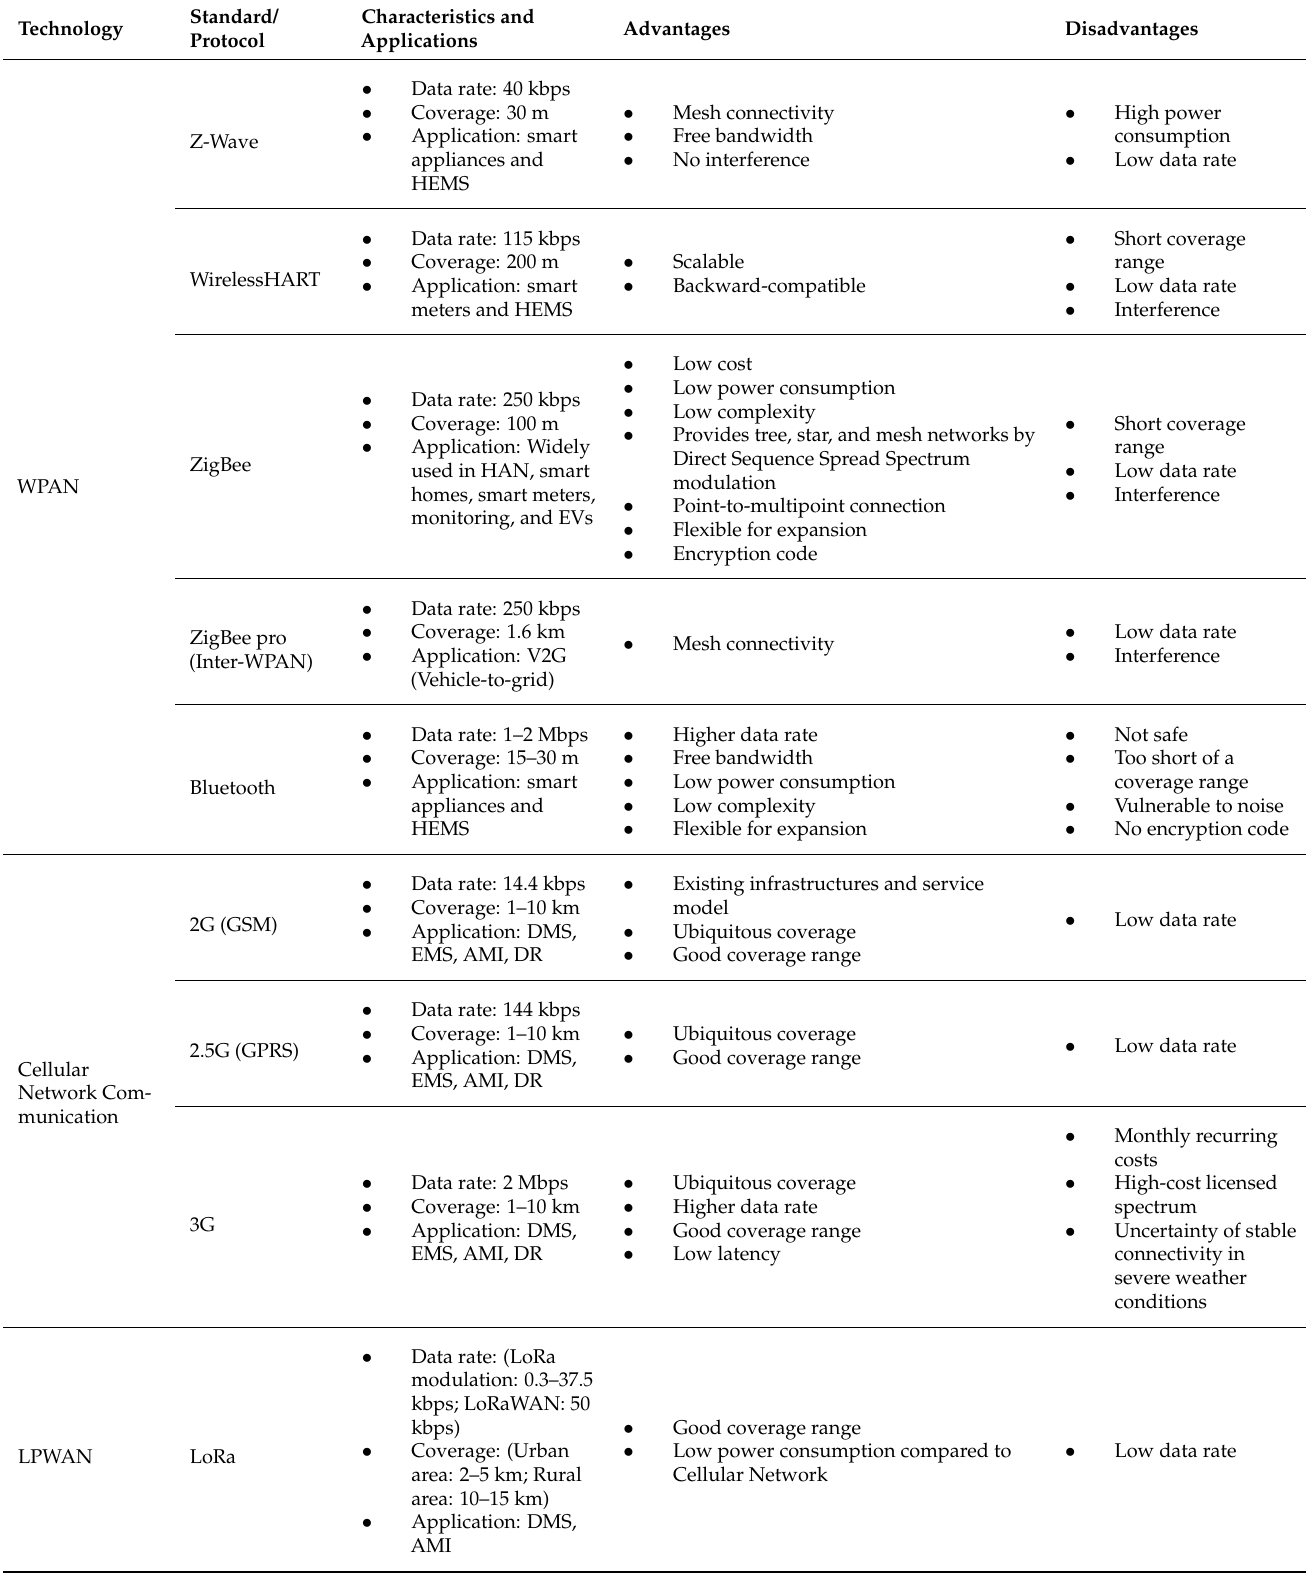
Table 12. Characteristics of LB WL technologies for the MGs communication